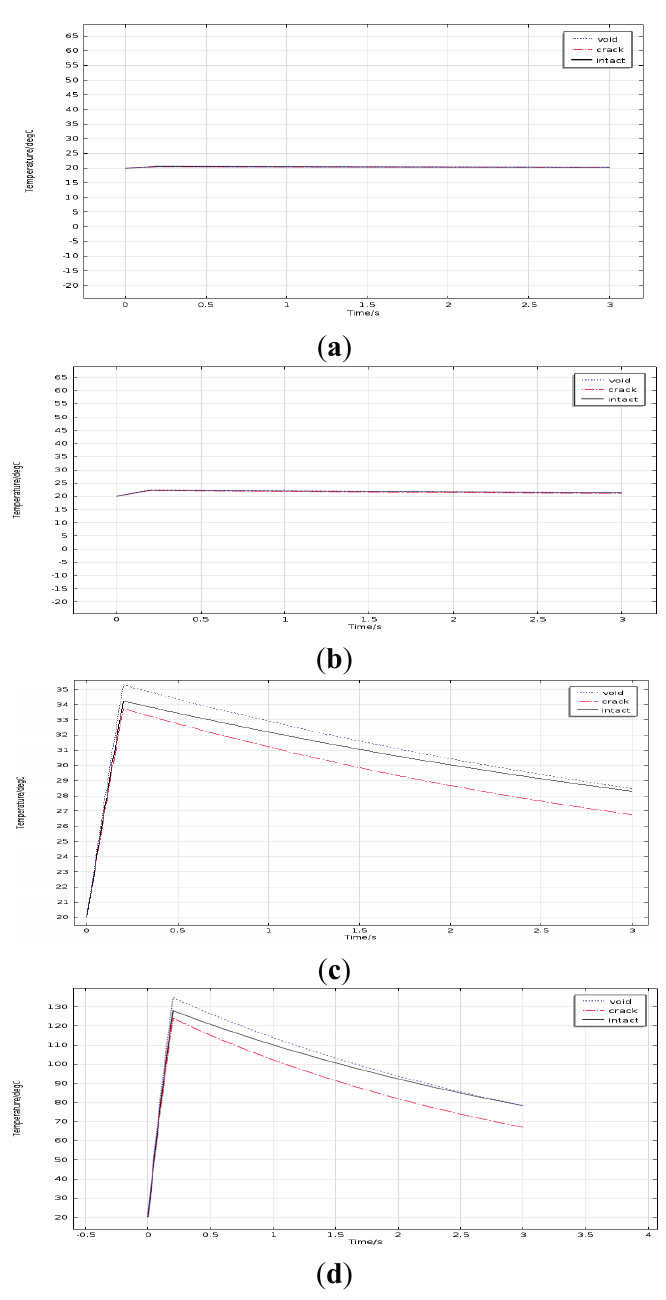
Figure 8. Temperature curves for different frequency: ( a ) 50 kHz; ( b ) 100 kHz; ( c ) 256 kHz; ( d ) 768